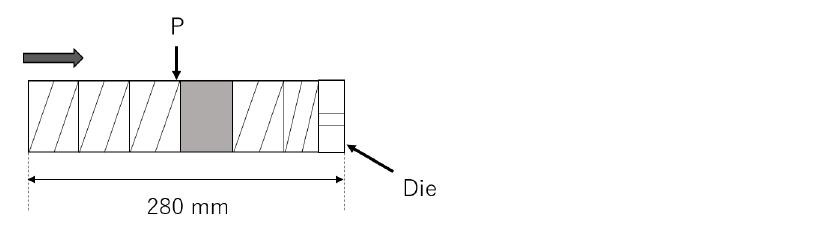
Figure 10. Screw configuration of experiment 1. The arrow indicates the direction of flow.